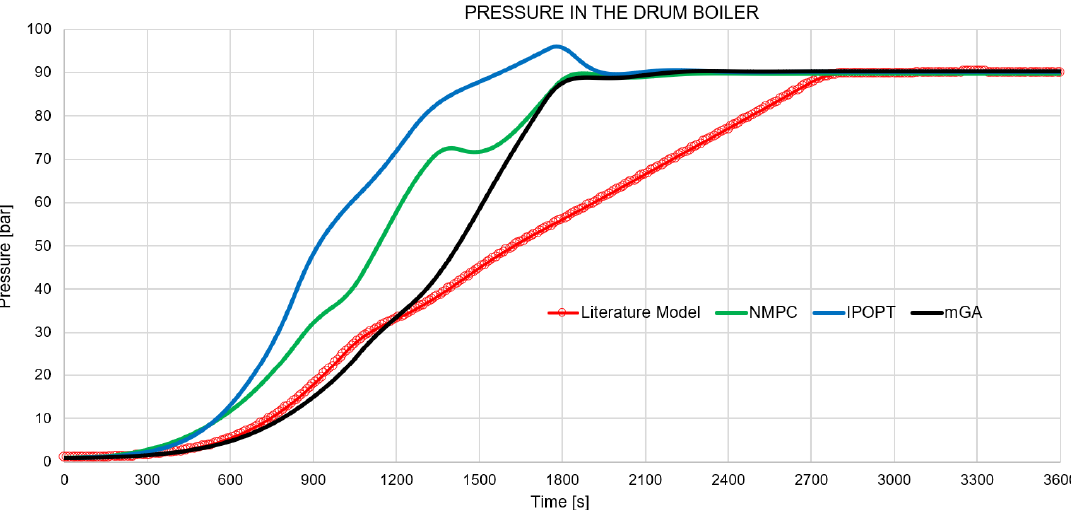
Figure 17. Results comparison between the curves of the operating reference profile available in the literature (red line), the optimized profiles reported by [17] (green line) and [20] (blue line), and the proposed approach (black line) for the pressure in the drum